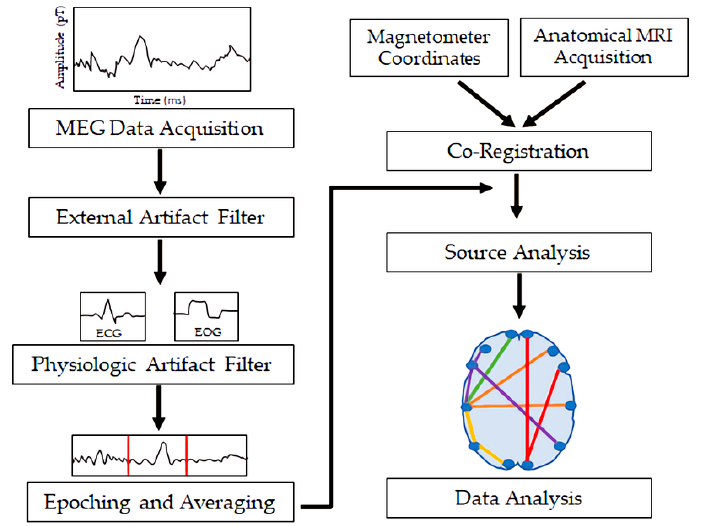
Figure 2. Overview of the processing steps involved in magnetoencephalography from data acqui- sition to data analysis. MEG = magnetoencephalography; ECG = electrocardiogram; EOG = elec- trooculogram; MRI = magnetic resonance imaging.